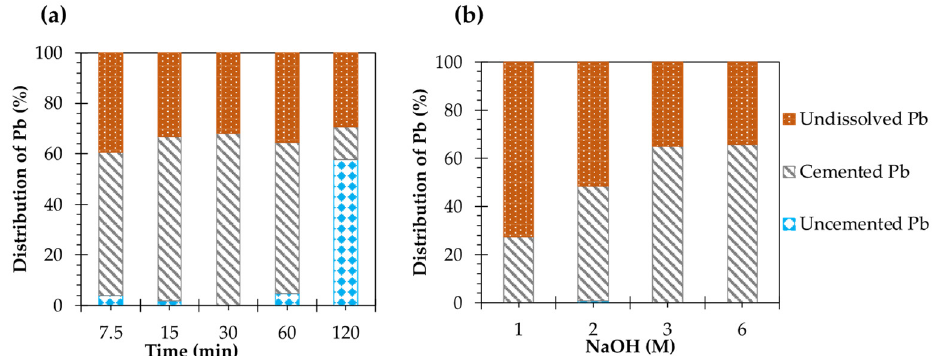
Figure 4. Effects of ( a ) leaching time and ( b ) NaOH concentration on cementation and distribution of Pb in leaching pulp when Al powder was added during ZPLR leaching (for interpretation of the references to color in this figure legend, the reader is referred to the web version of this article).